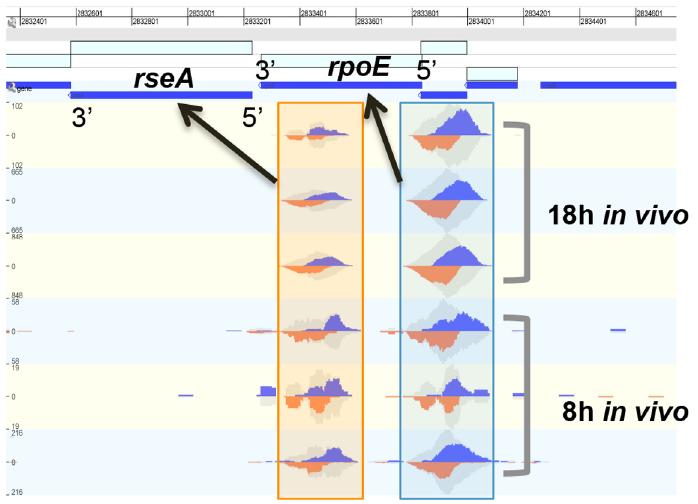
Fig 1. Visualization of the candidate binding sites (peak calls) upstream of rpoE and rseA . The peak calls for each replicate 8 h and 18 h are shown. The peaks in the blue box correspond to the binding site of σ E to 5 ’ region of the gene rpoE , while those in the orange box correspond to the binding site 5 ’ to the gene rseA .